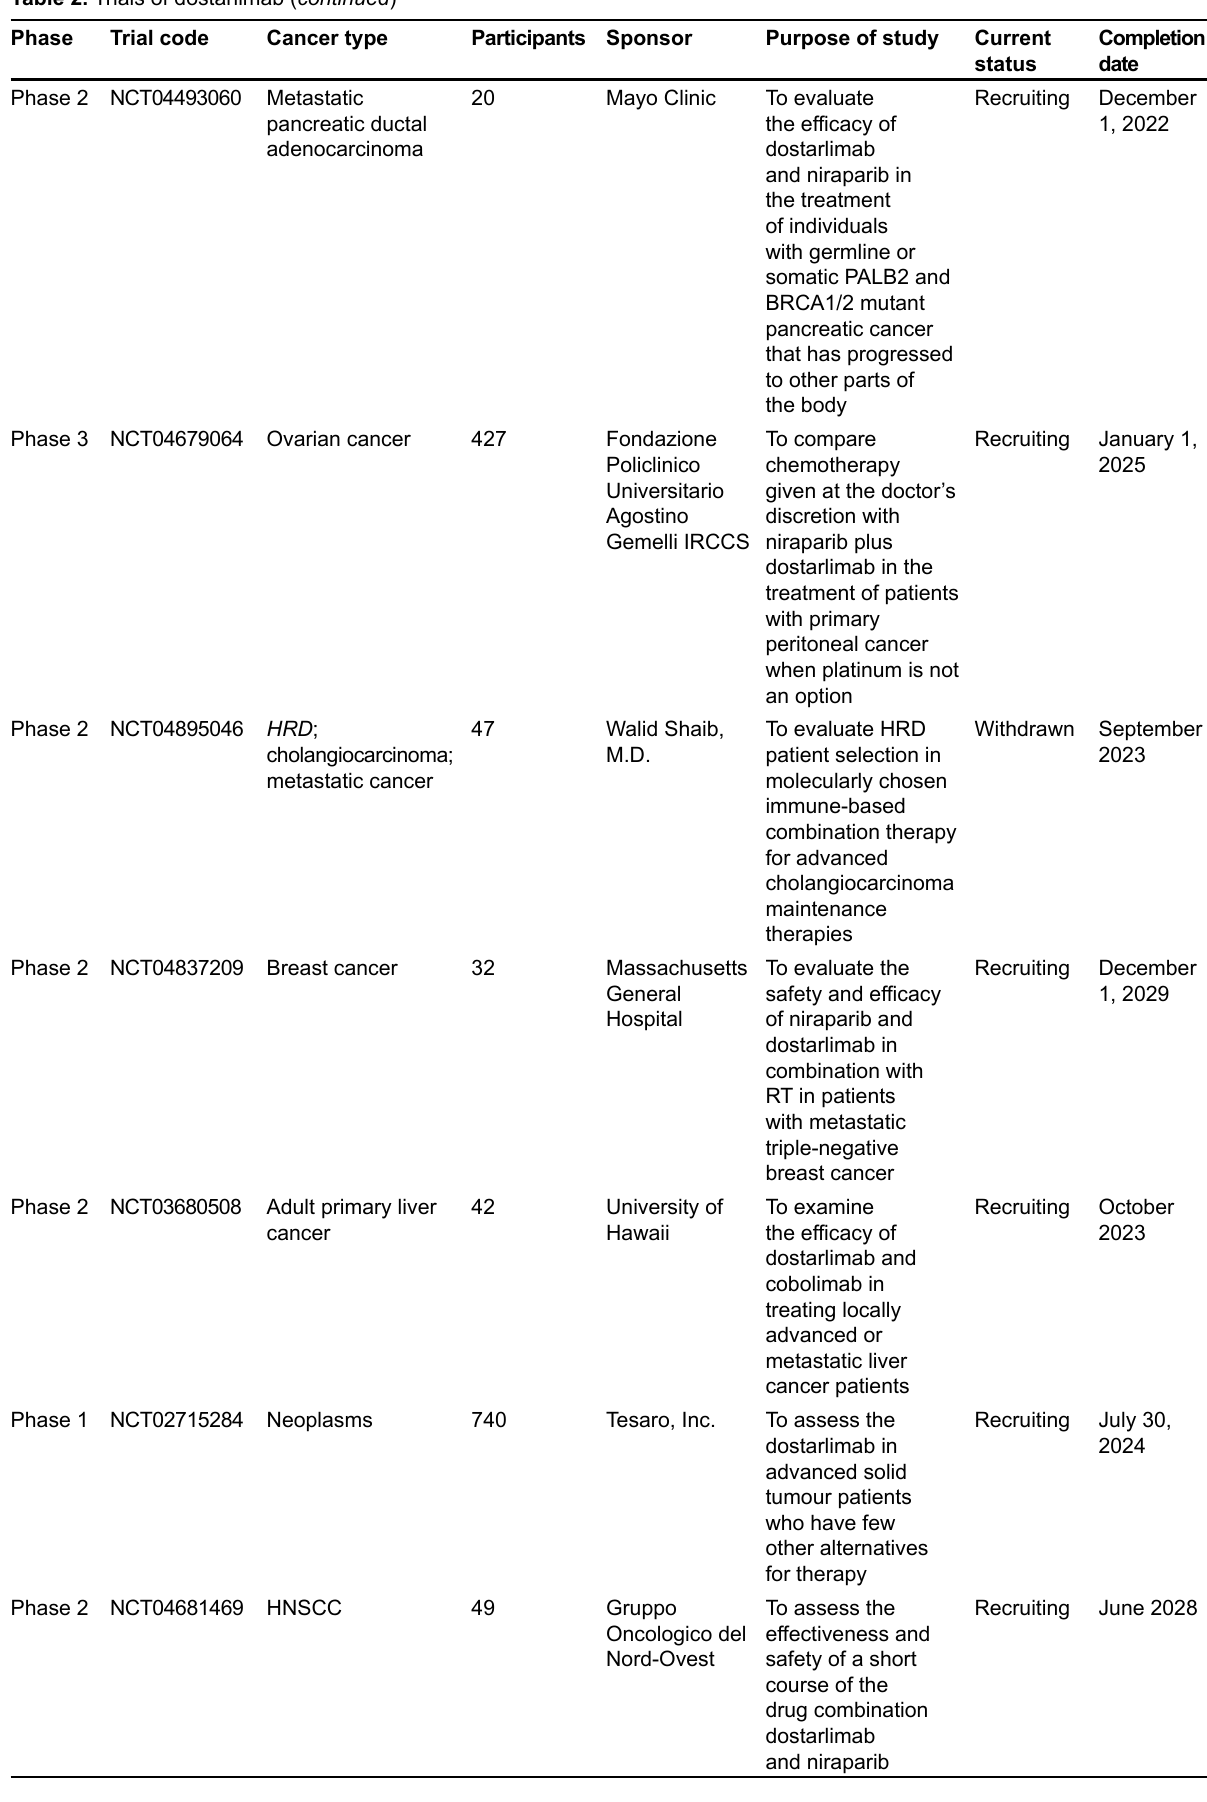
Table 2. Trials of dostarlimab ( continued )